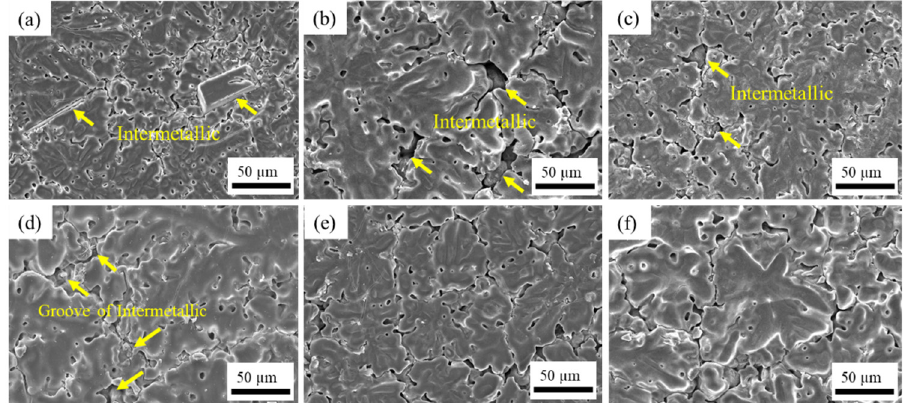
Figure 4. Surface micrographs of anodic oxide films with different pretreatment and sealing meth- ods: ( a ) 2-A, ( b ) 2-N, ( c ) 2-S, ( d ) 4-A, ( e ) 4-N, and ( f ) 4-S (SEM). ( a ) 2-A, ( b ) 2-N, ( c ) 2-S, ( d ) 4-A, ( e ) 4-N, and ( f ) 4-S (SEM).